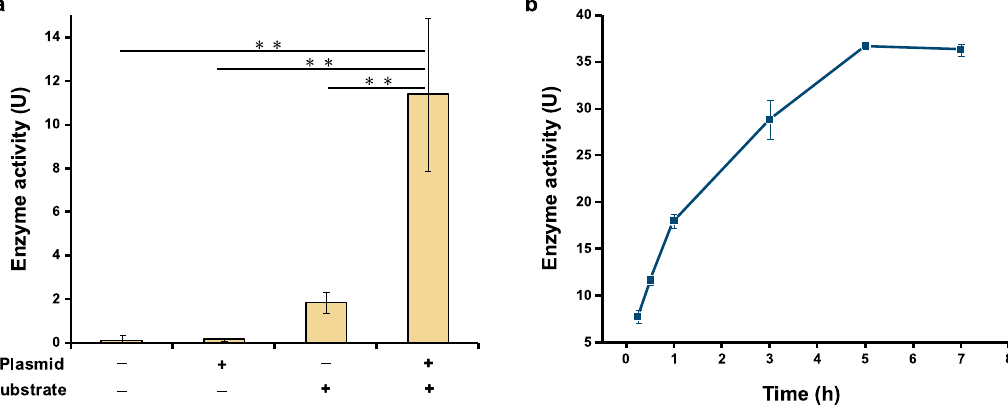
Figure 3. Detection of the serratiopeptidase activity. ( a ) Confirming the activity of cell-free expressed serratiopeptidase. ( b ) Time course of the enzyme activity measured within 7 h incubation. One enzyme unit (U) is defined as an increase of 0.01 absorption (at 450 nm) unit after 30 min of enzymatic reaction at 45 °C. Values show means with error bars representing standard deviations (s.d.) of at least three independent experiments. Student’s t ‐ tests were used for statistical analysis, and p < 0.05 indicated statistical significance (** p < 0.01).